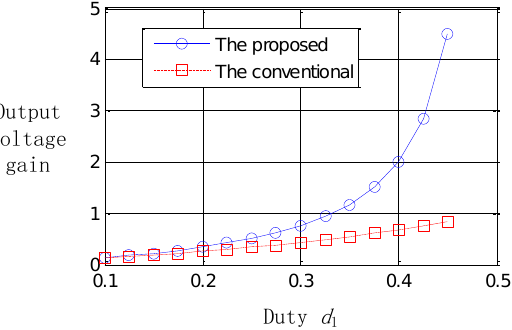
Figure 5. Gain comparison between the traditional and the proposed Ćuk converter in CCM.